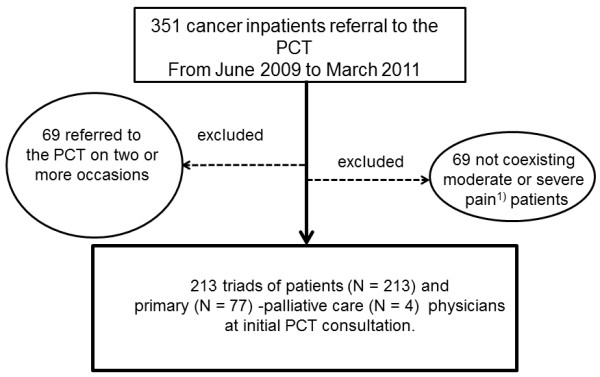
Patients in this study. PCT; Palliative Care Team 1) We defined moderate or severe pain as intensity of pain was rated ≧ 4 on the Numerical Rating Scale (NRS) by patients, or documented ≧8 on the Abbey Pain Scale (APS) by palliative care physicians at the initial consultation to a PCT.